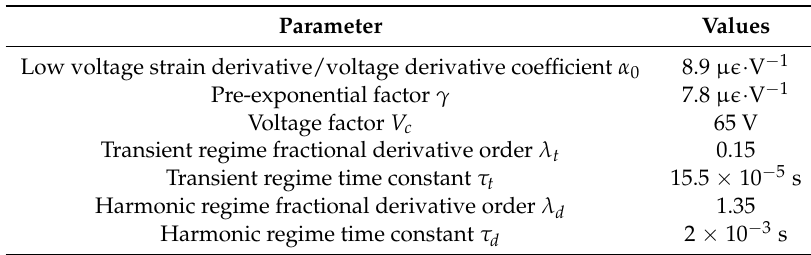
Figure 8. Low-frequency characterization taking into account transient stage. Theoretical plot has been obtained using Equation (10). Table 1. Model